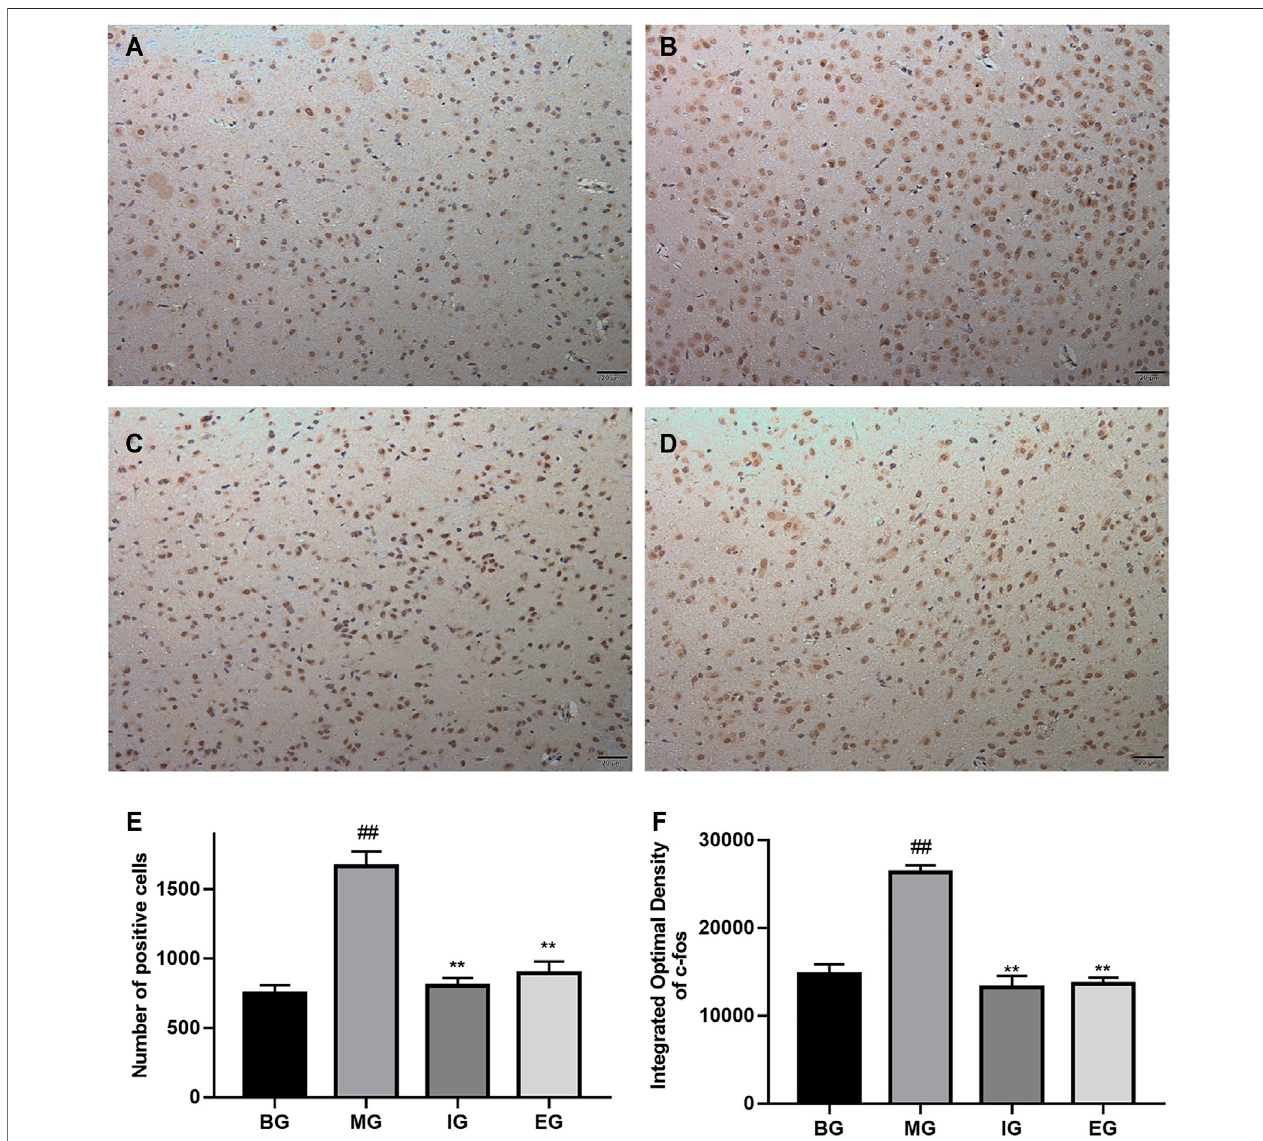
FIGURE4| Theresultofemodinonc-FosneuronsinthecerebralcortexafterNTGtreatment(coronalcut).Immunohistochemistryphotos: (A) BG, (B) MG, (C) IG, (D) EG;bar graph: (E) thenumberofc-Fospositivecells; (F) Integral Optical Density(IOD); photos weremagni fi ed200times:scalebar (cid:1) 20 μ m;datawasexpressed as mean ± SD ( n (cid:1) 6), ## p < 0.01 compared with the BG; ** p < 0.01, compared with the MG.